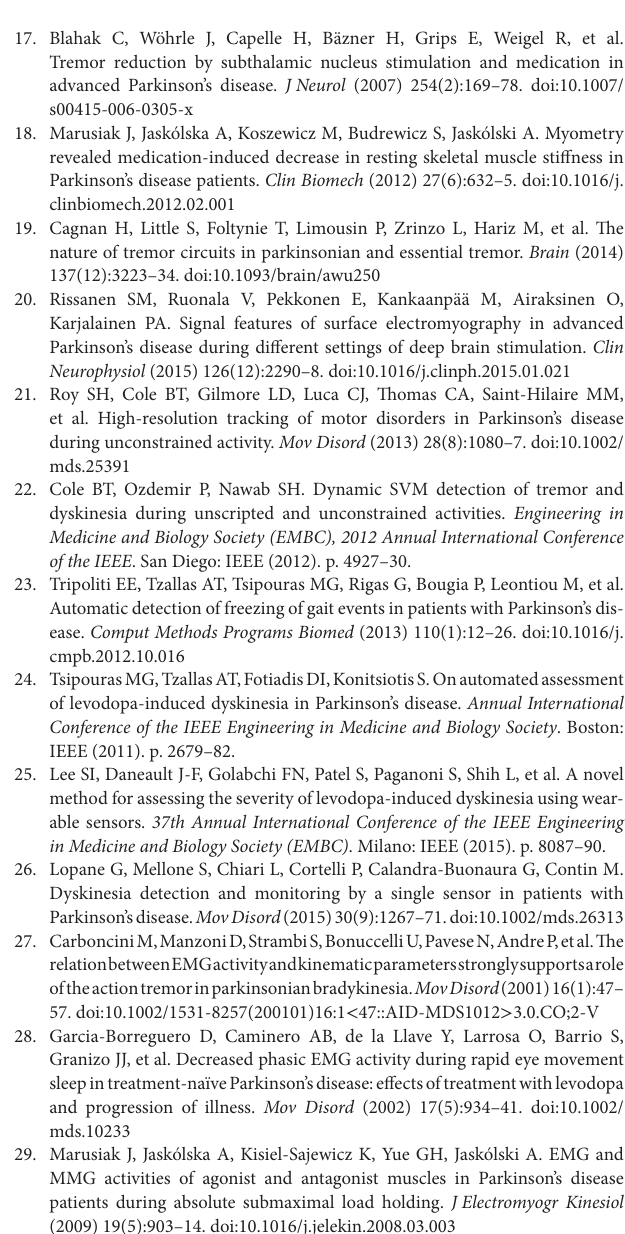
right side. There is more tremor-like activity in kinematic signals of phase II than others. FigUre s2 | Basis vectors BV1–BV4 of the data set determined by PCA. BV1 denotes EMG histogram peak height, BV2 peak width, BV3 the side differences, and BV4 is a partial mixture of side differences and peak height. FigUre s3 | Principal components PC1 and PC2 in phases II–IV, normalized to the phase I. The phase II and the phase III show similar features. The phase IV indicates that the effect of the patients own medication is milder than that of the levodopa test dose (phase III). The phase I for each patient is marked with a solid circle while the hollow circles indicate the change from the phase I. FigUre s4 | Left and right arm EMG spectral power during passive extension– flexion task in phases I and III for each patient. White colour denotes higher spectral intensity. The EMG spectral power decreases from the phase I to the phase III in passive extension–flexion